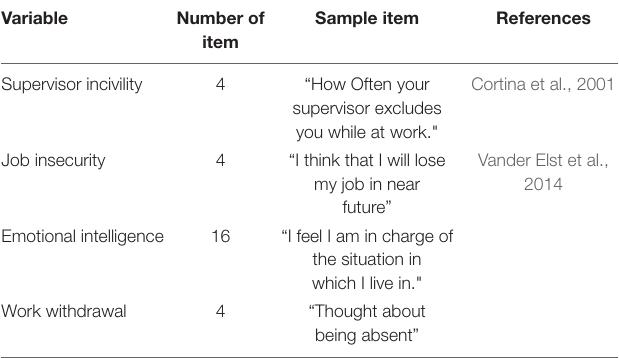
TABLE 1 | Measurement of variables.